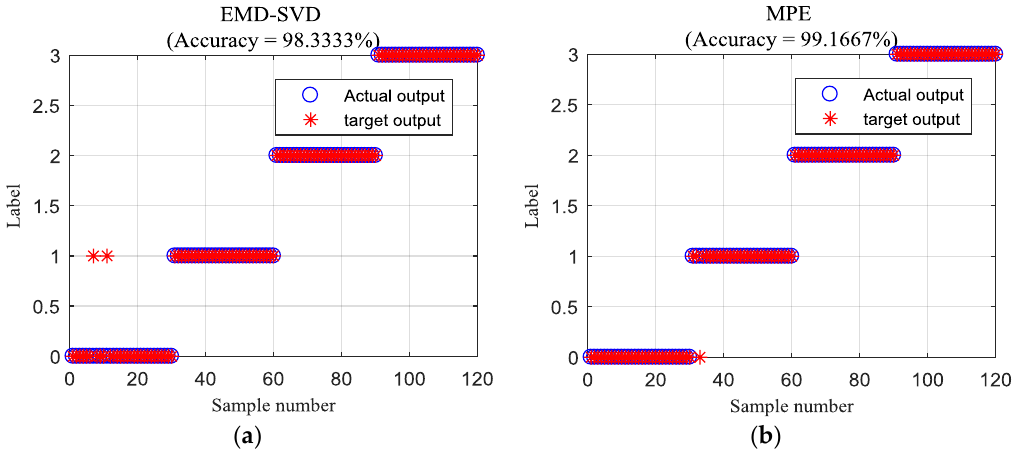
Figure 12. The recognition results of: ( a ) EMD-SVD; ( b ) MPE.